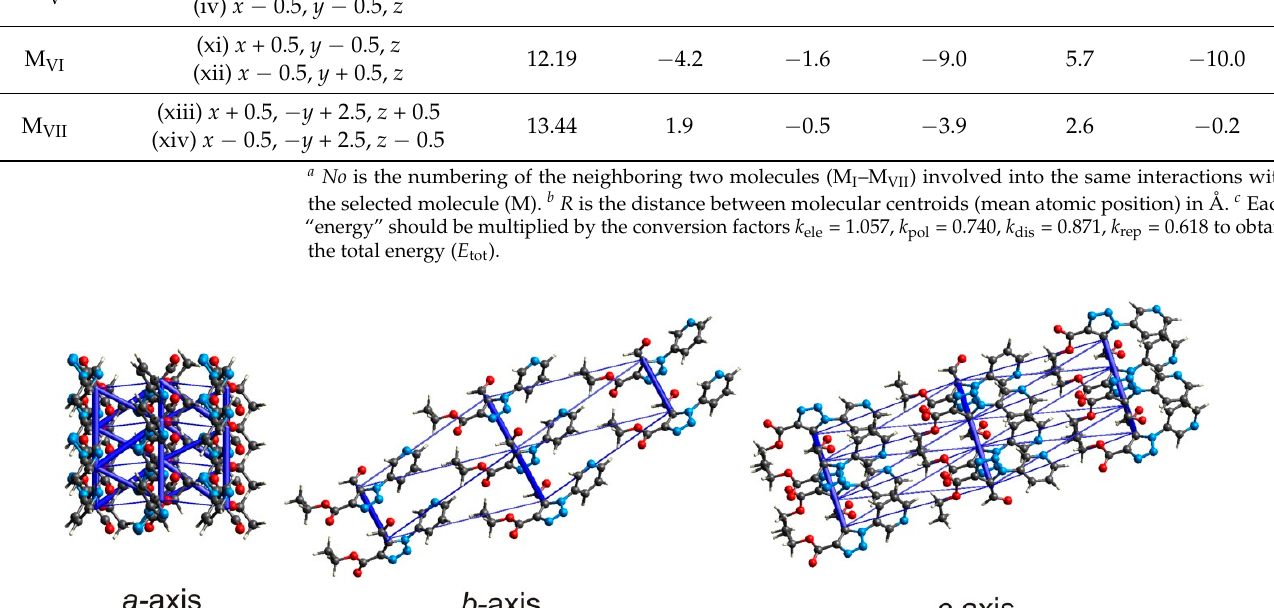
Figure 4. ( a ) Hirshfeld surface for the title molecule mapped with d norm over the range − 0.140 to 1.238 a.u. showing n → π * and C–H···O interactions. Fingerprint plots resolved into ( b ) O···H/H···O and ( c ) N···H/H···N contacts. Neighboring molecules associated with close contacts are also shown.